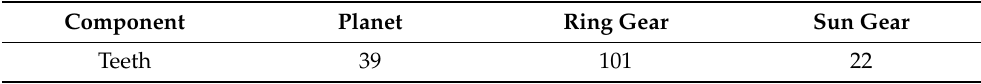
Figure 4. Internal structure of the planetary gearbox and the location of the accelerometer. Table 1. Teeth number information of the second-stage planetary